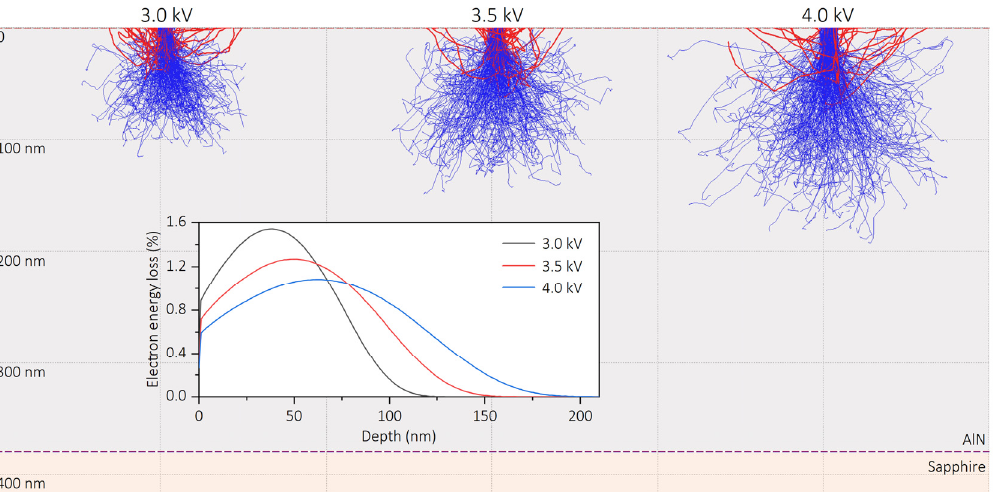
Figure 6. Monte Carlo Simulations of electron trajectory in the AlN sample under different excitation voltages, in which the blue trajectories originate from absorbed electrons and the red trajectories come from backscattered electrons. The inset represents the electron energy loss as a function of the penetration depth in the AlN sample.